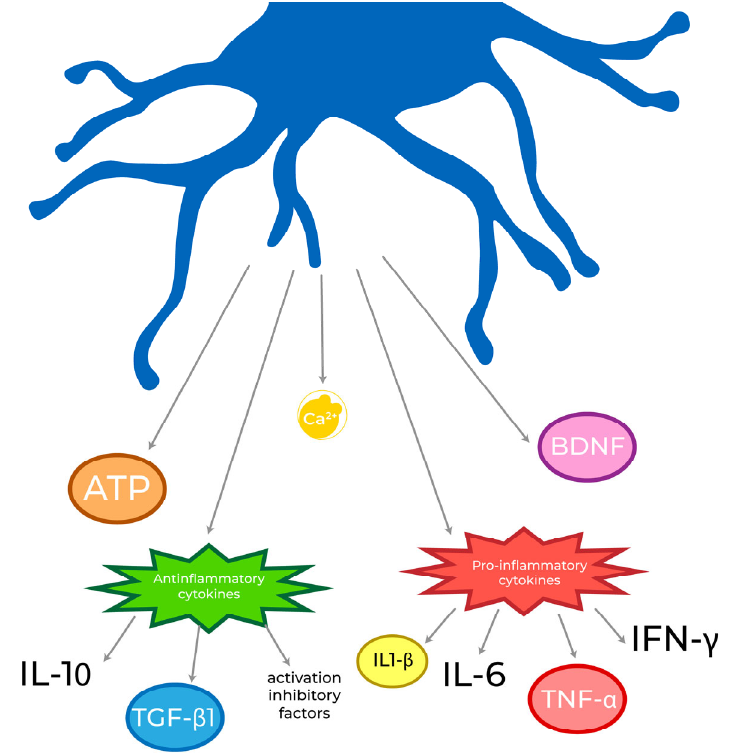
Figure 2. The pattern of secreted molecules that microglia release in the extracellular environment changes according to the health state of the CNS. Microglia are able to release both anti-inflammatory (IL-10, TGF-1 β , and inhibitors of activation) and pro-inflammatory (IL-1 β , IL-6, TNF- α , and IFN- γ ) mediators, together with ATP, BDNF, and Ca 2+ . Through this highly regulated mechanism, they are able to communicate with other cells of the CNS and coordinate a specific response to a dangerous stimulus.